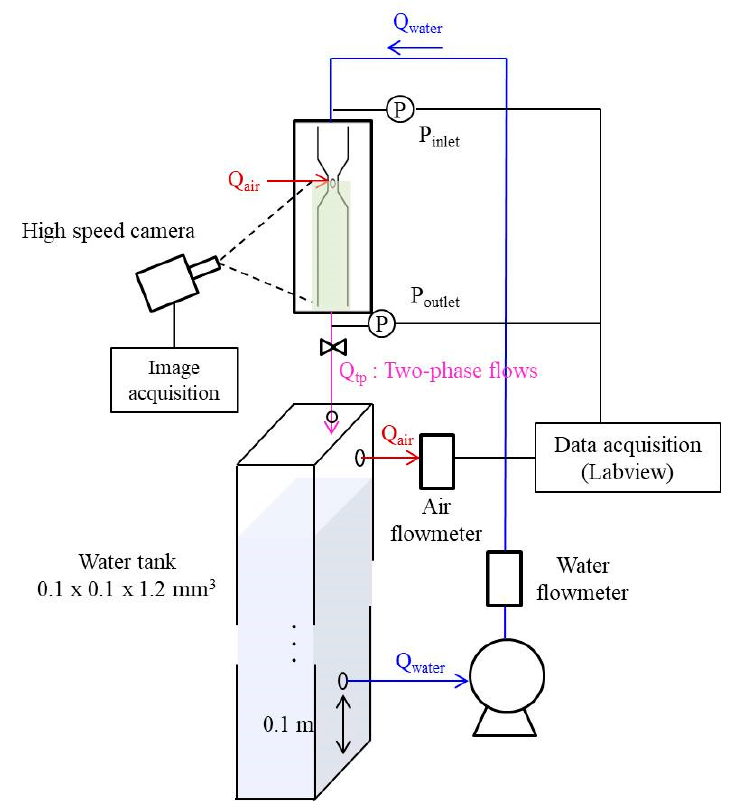
Figure 2. Experimental setup. The pressure ratio at the inlet and outlet (P r = P outlet /P inlet ) is set during the exper- iments. When the opening ratio of the shut-off valve varies, the pressure ratio changes, which affects the water flow rate depending on the diverging angle. In all cases, experi- ments are performed from the smallest controllable pressure ratio of 0.02, to the maximum pressure ratio (P r_max ) where air is not entrained. Table 1 shows the maximum pressure ratio according to the water flow rate and the diverging angle. Prior to every data collection, stabilization to reach a steady state is performed for a minute. The data signals of air flow rate and inlet and outlet pressures are synchronized by the Labview program and a total of 5000 data are collected at a 1 kHz sampling